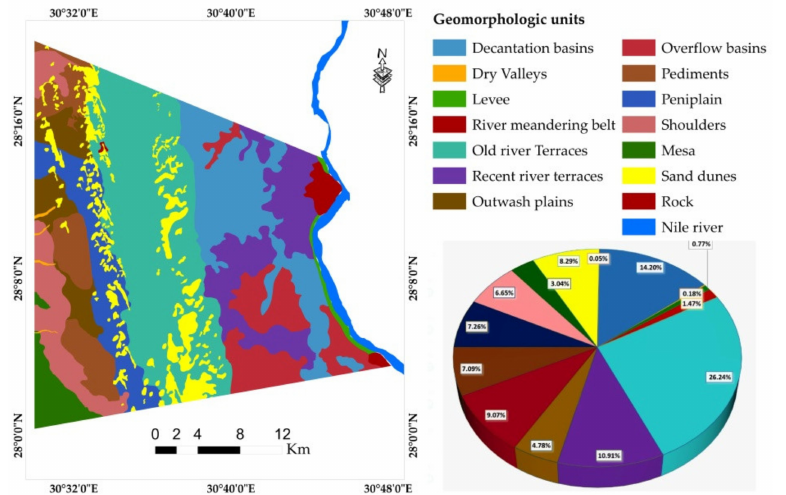
Figure 6. Geomorphologic units within the study area and a pie chart illustration of the percentage of their